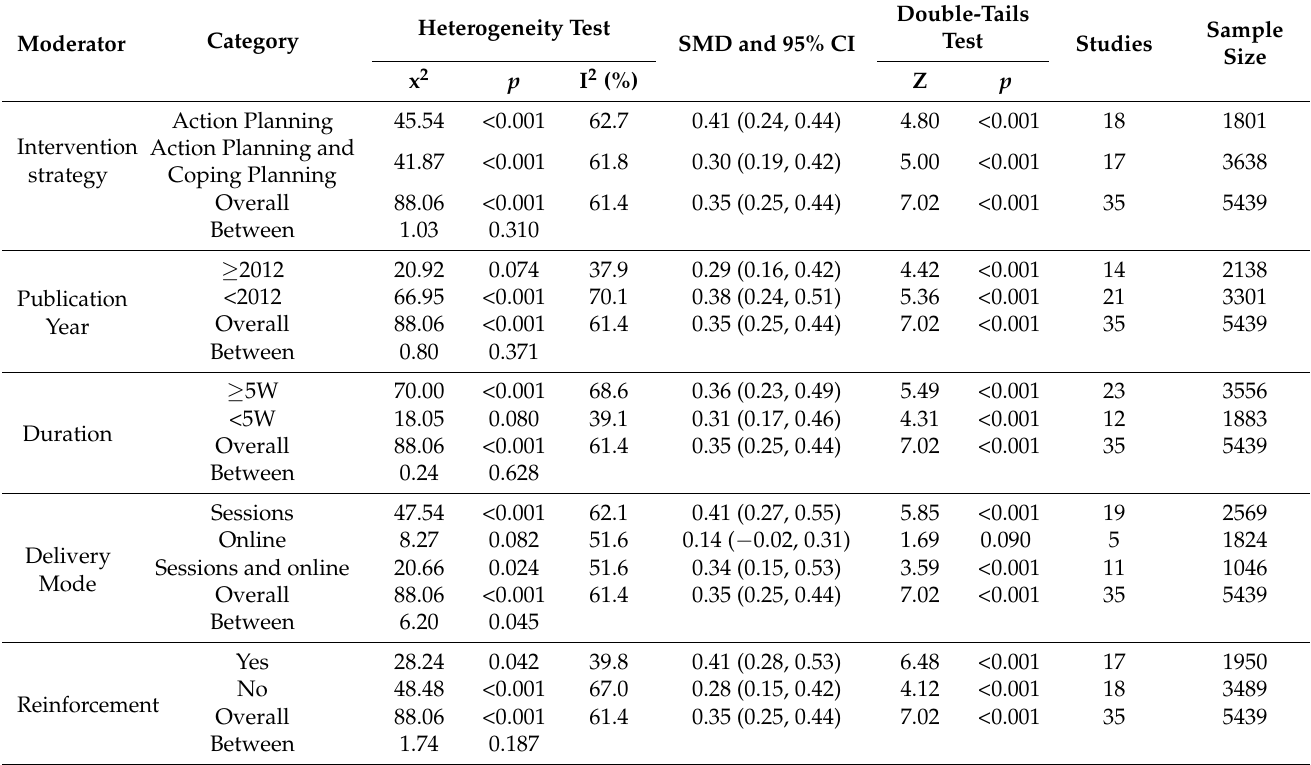
Table 2). The effect sizes varied between − 0.12 and 0.94 across the studies. A funnel plot indicated that there was no publication bias (shown in Figure S1), but the quantitative Table 2. Primary results and subgroup